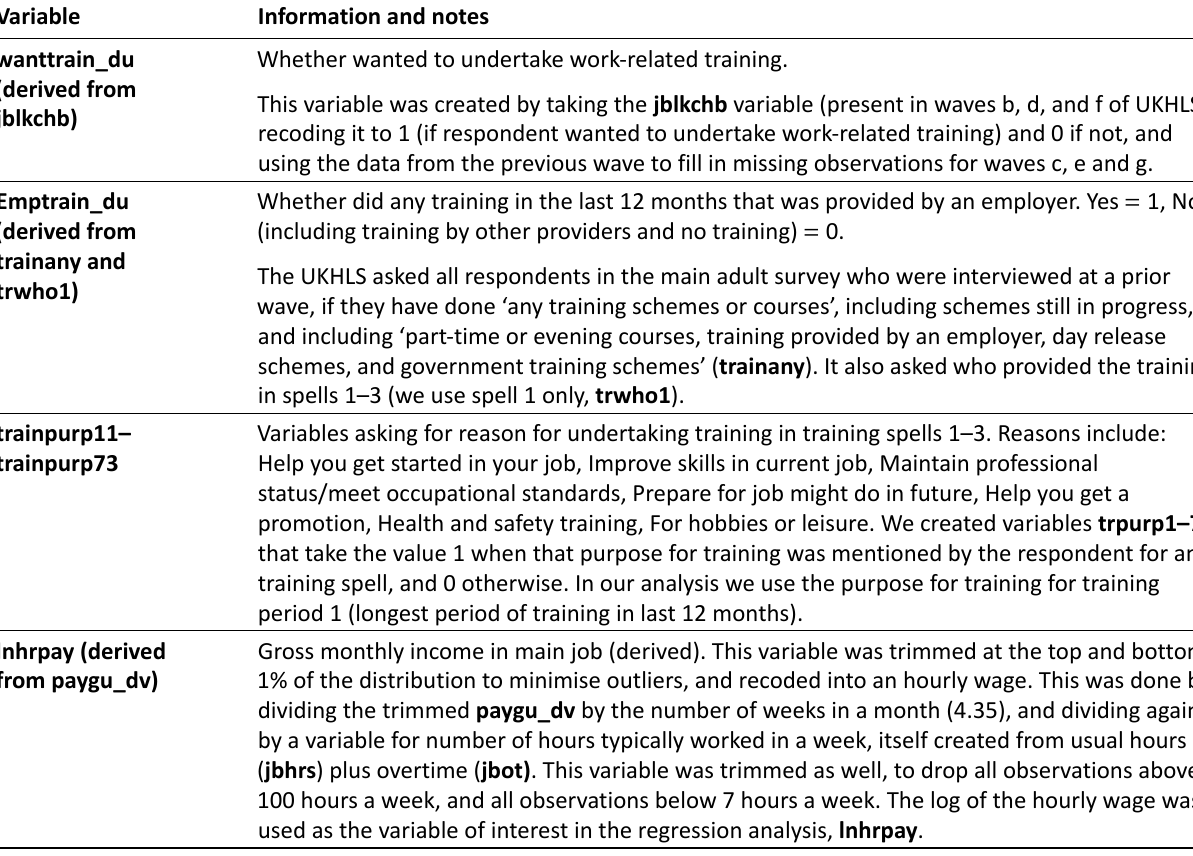
Table A1. Key variables for